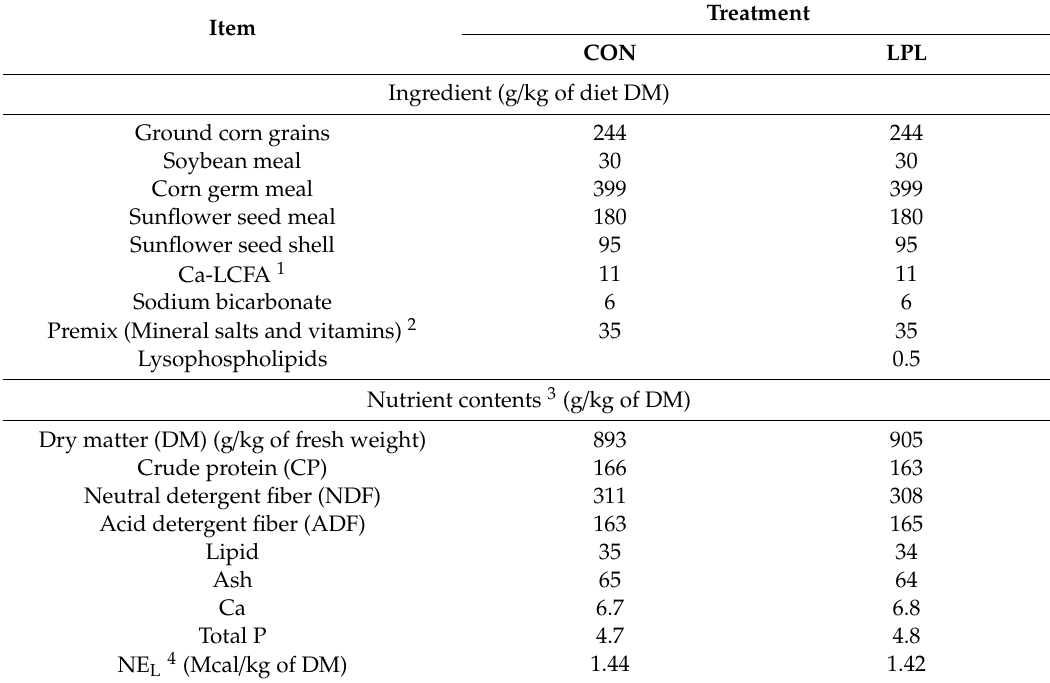
Table 1. Ingredients and nutrient contents of experimental diets supplemented without control diet (CON) or with lysophospholipids